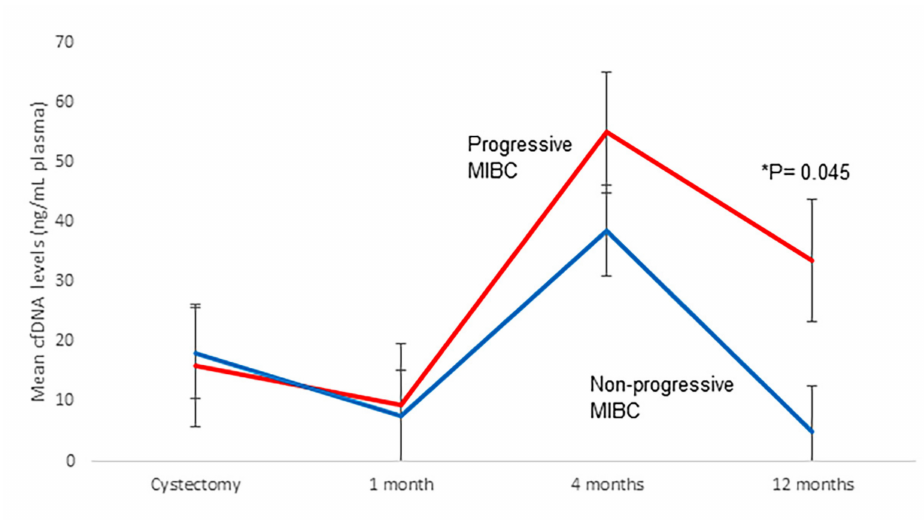
Figure 2. Analysis of cfDNA levels in MIBC patients according to tumor